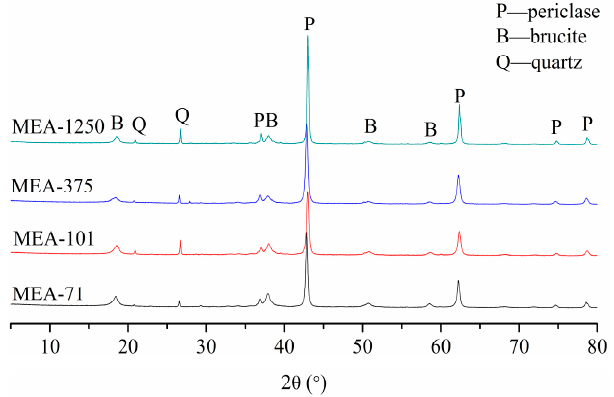
Figure 4. X-ray diffraction (XRD) patterns of compacted MEAs cured in water at 40 °C for 3 days.